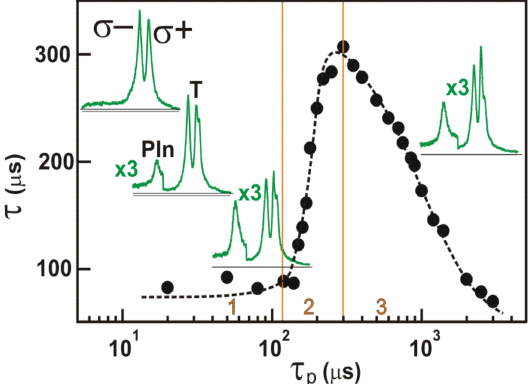
Figure 2. Dependence of the PRR signal decay time τ on the pumping pulse duration τ p , measured at the pump power of 50 µ W for sample 2 (black dots). The insets (left to right) show the shape of the photoluminescence spectra measured for different values of pump pulse duration, τ p = 10 µ s, 30 µ s, 100 µ s, and 1000 µ